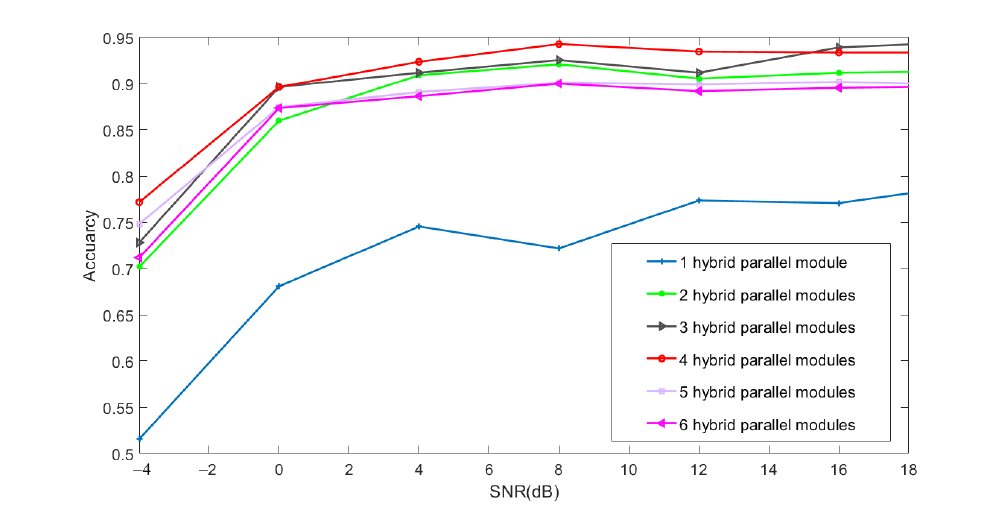
Figure 6. The performance of different number of hybrid parallel